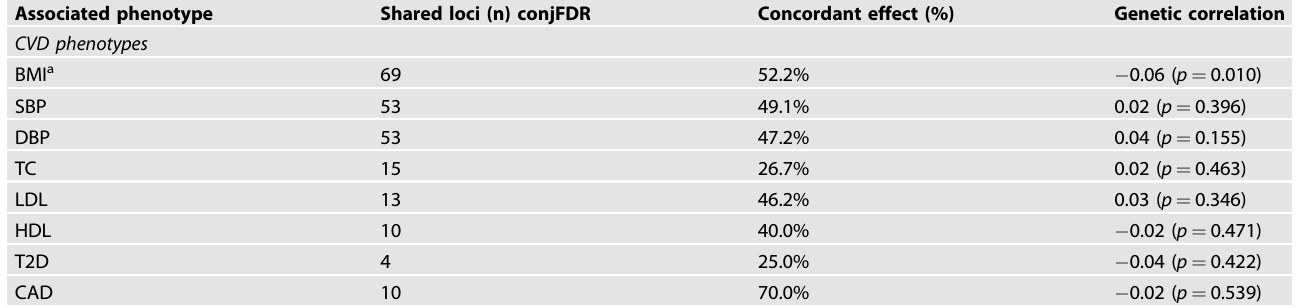
Table 2. Shared loci between bipolar disorder and cardiovascular disease